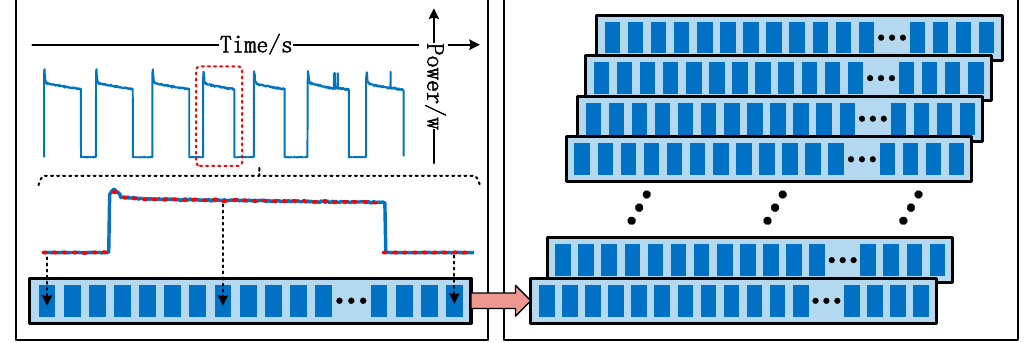
Figure 1. One-dimensional convolutional neural network input graph.